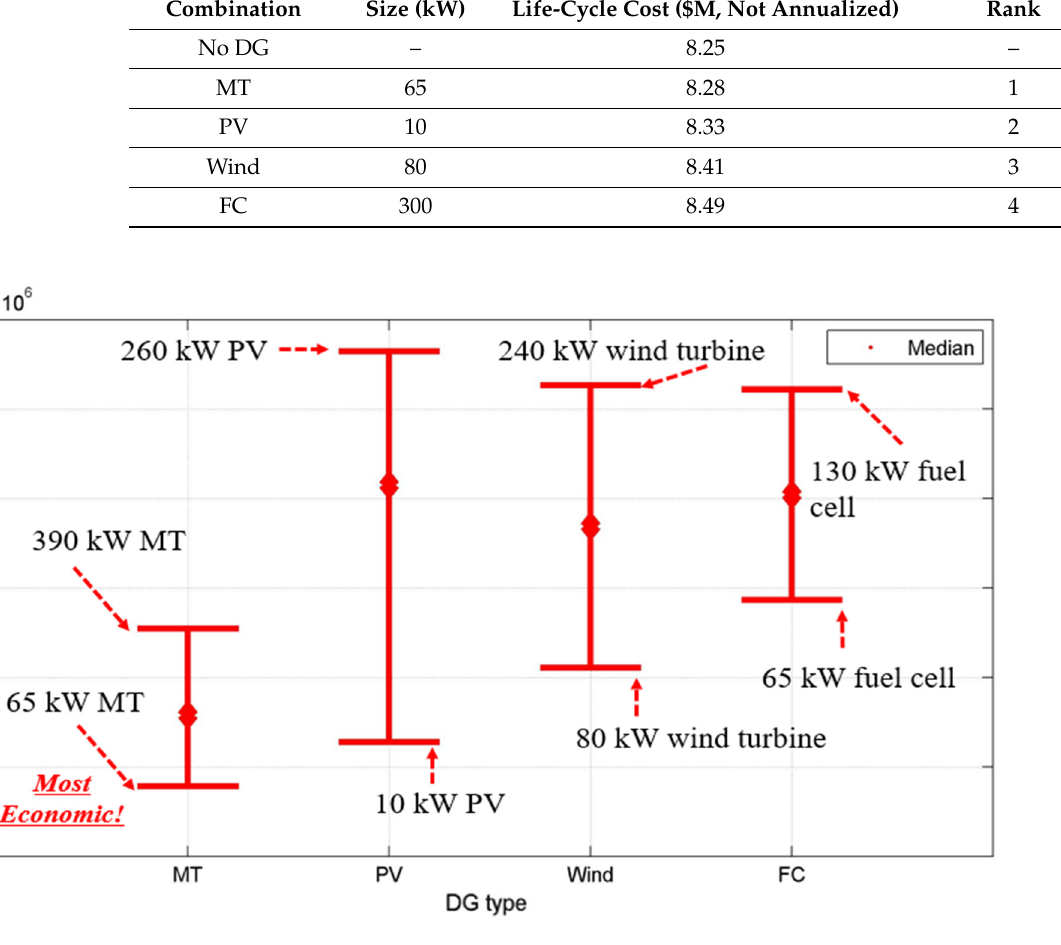
Figure 8. Life-cycle cost variations without AbCs.